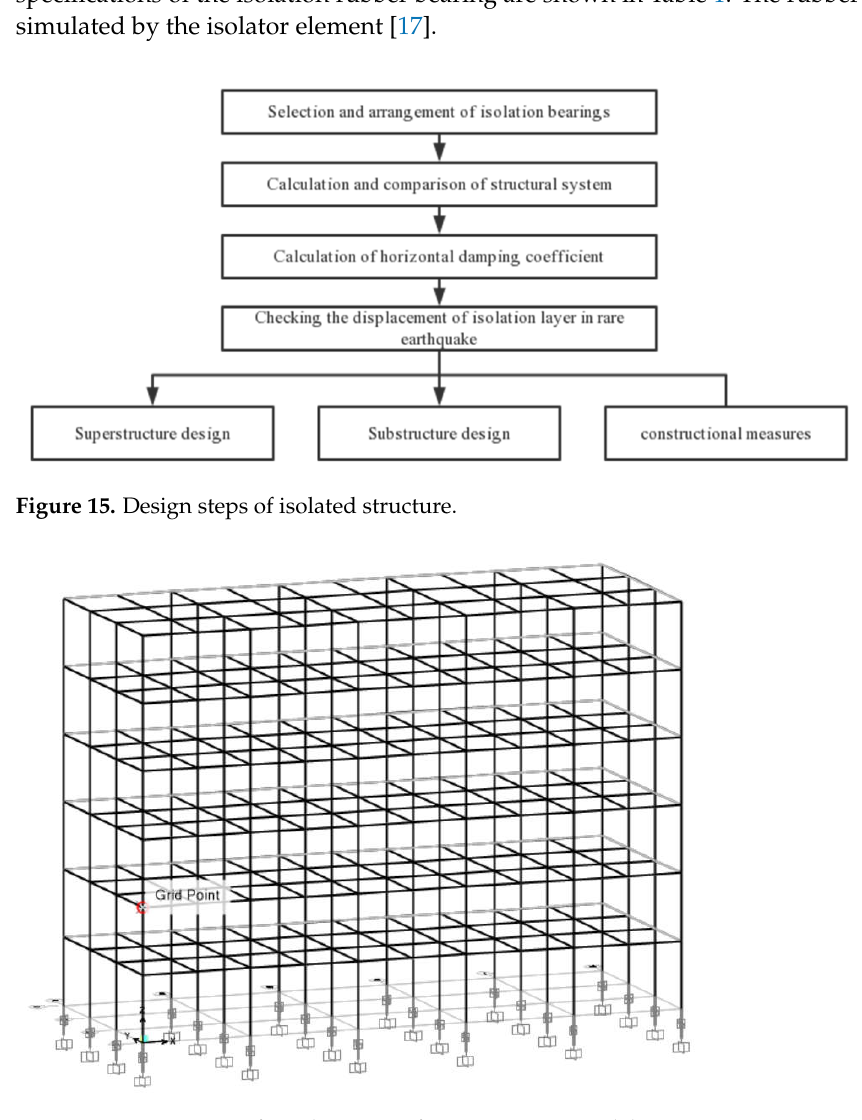
Figure 17. Layout of isolation layer.